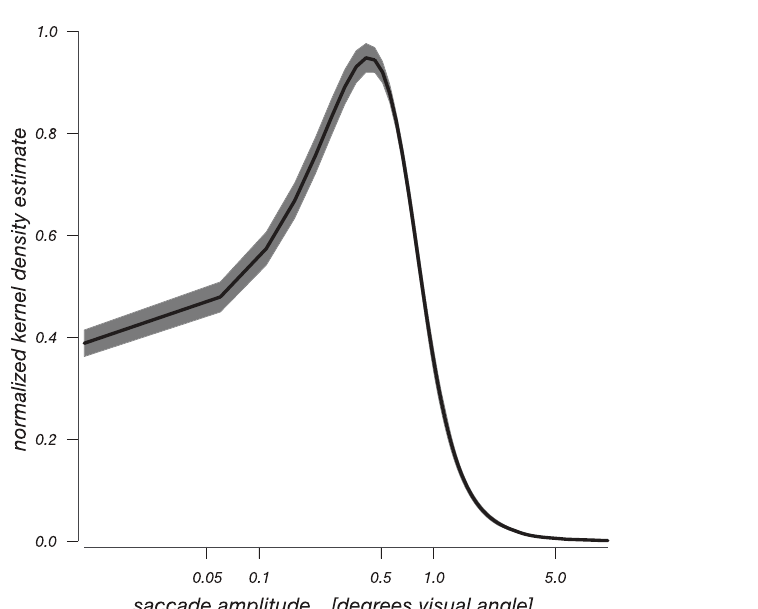
Fig 2. Saccade amplitude distribution. Kernel density estimates of Eyelink-detected saccade amplitude, averaged across conditions. The mode of this distribution falls within one degree of visual angle, a conventional criterium for the classification of microsaccades. Saccade frequency was around 0.8 Hz, and did not differ across